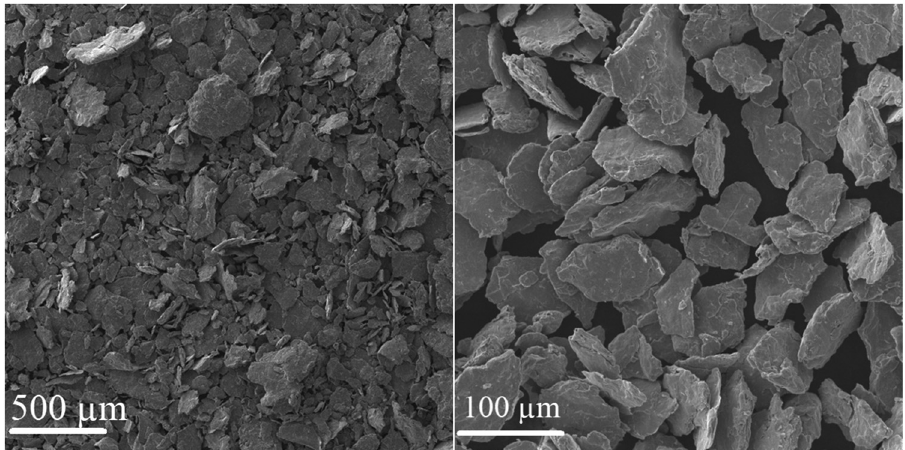
Figure 2: Morphology of initial EI961 powder.